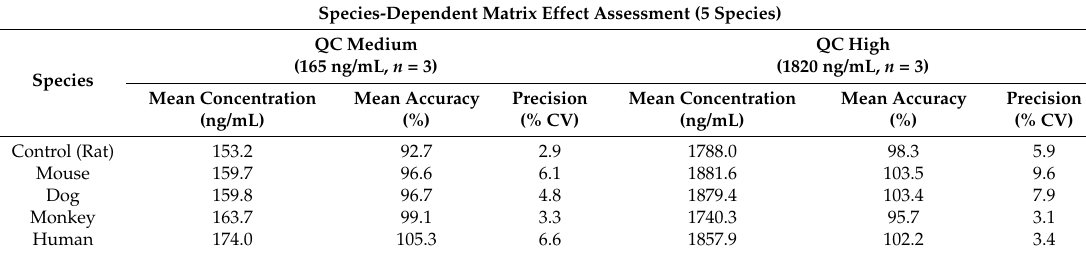
Table 4. The Species-dependent matrix effect of vipadenant.